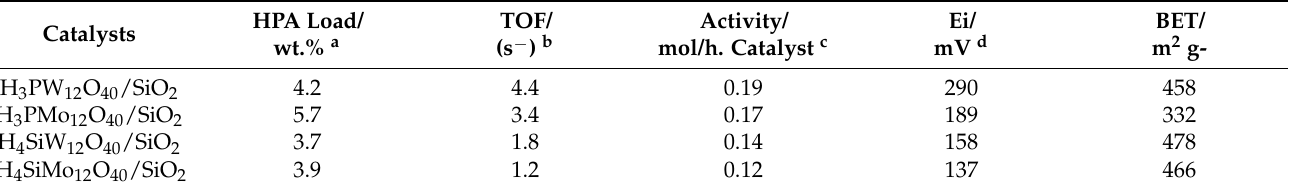
Table 2. Impact of HPA load, the strength of acidity, and surface area on the activity and TON achieved in reactions of glycerol condensation with acetone a,b,c,d (adapted from ref. [21]).